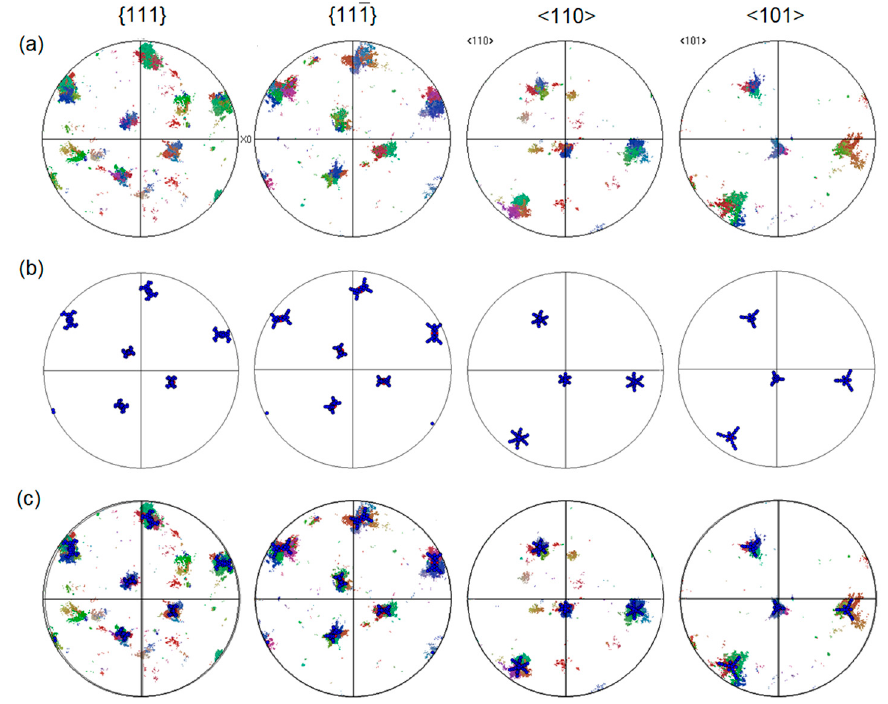
Figure 15. Pole figures of the planes {111} and {11 1(cid:3364) } and directions <110> and <101> of the B19 ′ martensite ( a ) mapped by TKD in Figure 13, and ( b ) simulated with all the variants generated by the ORs A, AQ, C, CQ, I, and A-C. ( c ) Overlap of the experiments with the simulations.